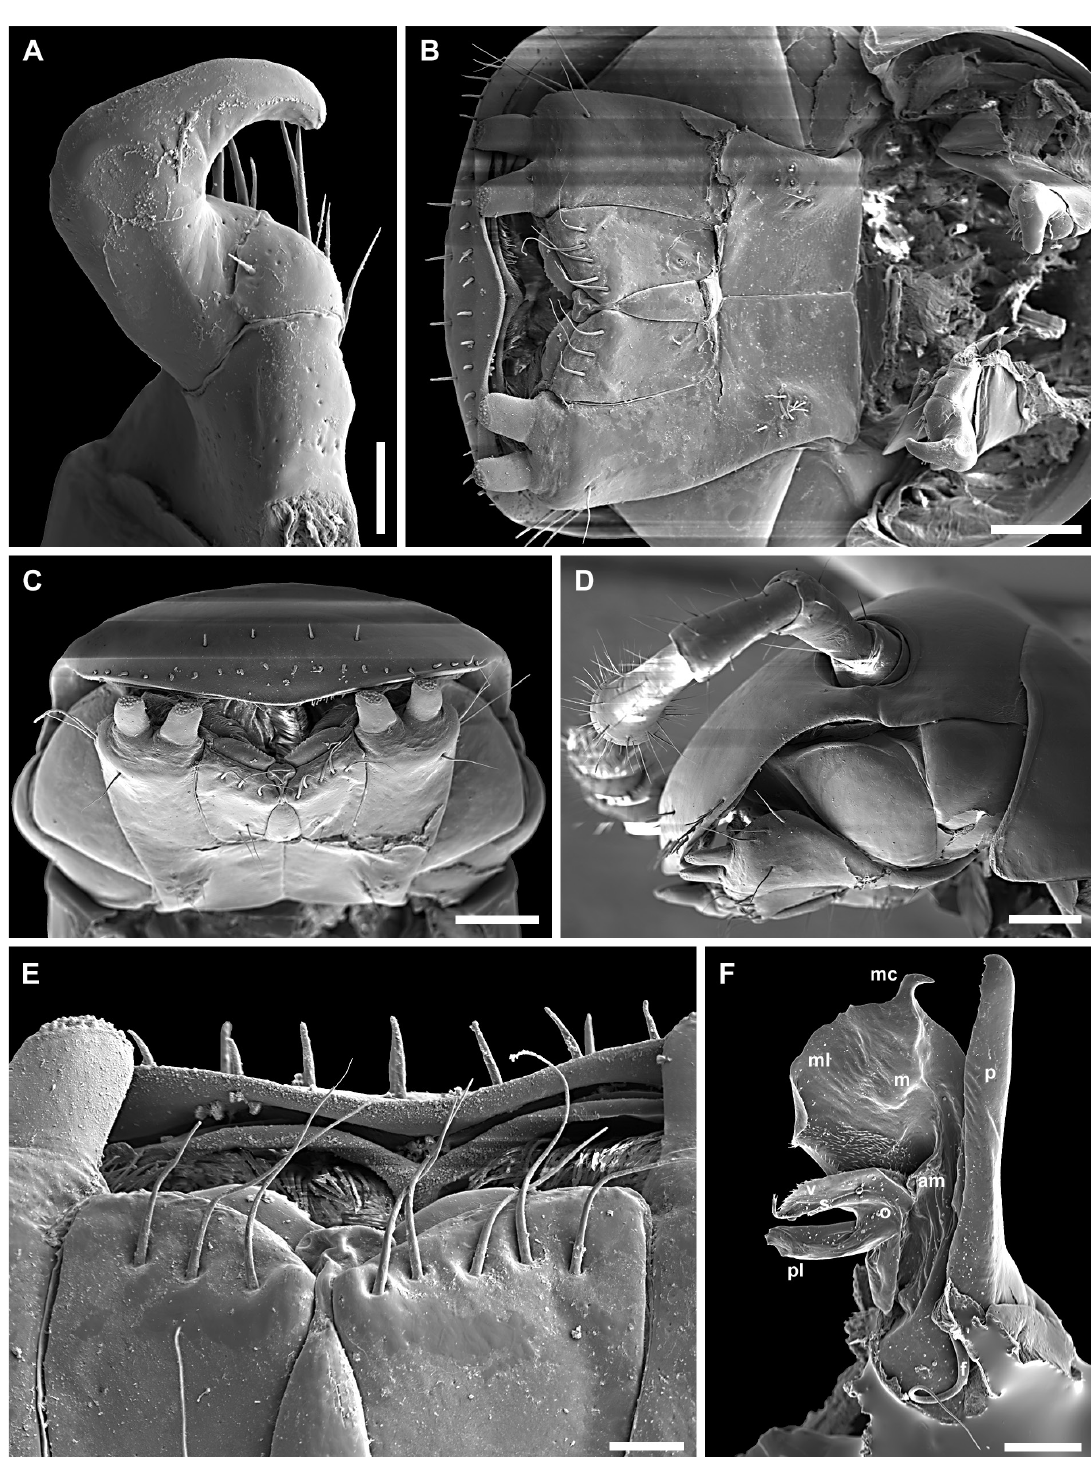
Fig. 9. Leucogeorgia longipes Verhoeff, 1930, ♂ from Dolabistavi Cave (SMNG). A . Left leg 1, lateral view. B . Head, ventral view. C . Head, anterior view. D . Head, lateral view. E . Anterior part of head, ventral view. F . Right gonopods, mesal view. Abbreviations: am = accessory membrane; f = flagellum; m = mesomere; mc = mesomeral claw; ml = mesomeral lamella; o = opisthomere; p = promere; pl = protective lamella; s = solenomere; v = velum. Scale bars: A, E = 0.05 mm; B–D = 0.2 mm; F = 0.1